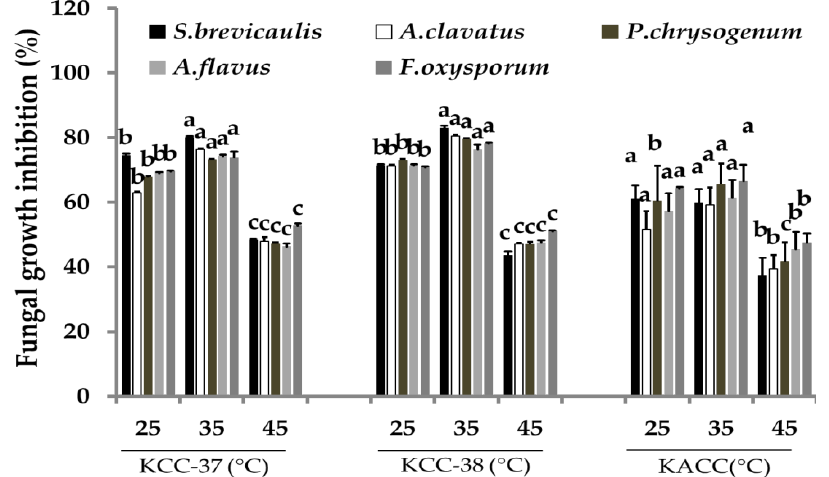
Figure2. E ff ectof L.plantarum KCC-37and L.plantarum KCC-38CFMproducedatdi ff erenttemperatures Figure 2. Effect of L. plantarum KCC-37 and L. plantarum KCC-38 CFM produced at different ( ◦ C) on fungal growths (% of fungi growth inhibition, compared to control). Data represent mean ± temperatures (°C) on fungal growths (% of fungi growth inhibition, compared to control). Data STD of three replicates. Di ff erent letter a, b, and c within a column indicates significances di ff erences Appl. Sci. 2020 , 10 , x FOR PEER REVIEW represent mean ± STD of three replicates. Different letter a, b, and c within a column indicates between cell-free metabolites (CFM) produced at di ff erent temperatures ( p < 0.05). significances differences between cell-free metabolites (CFM) produced at different temperatures ( p < 0.05).